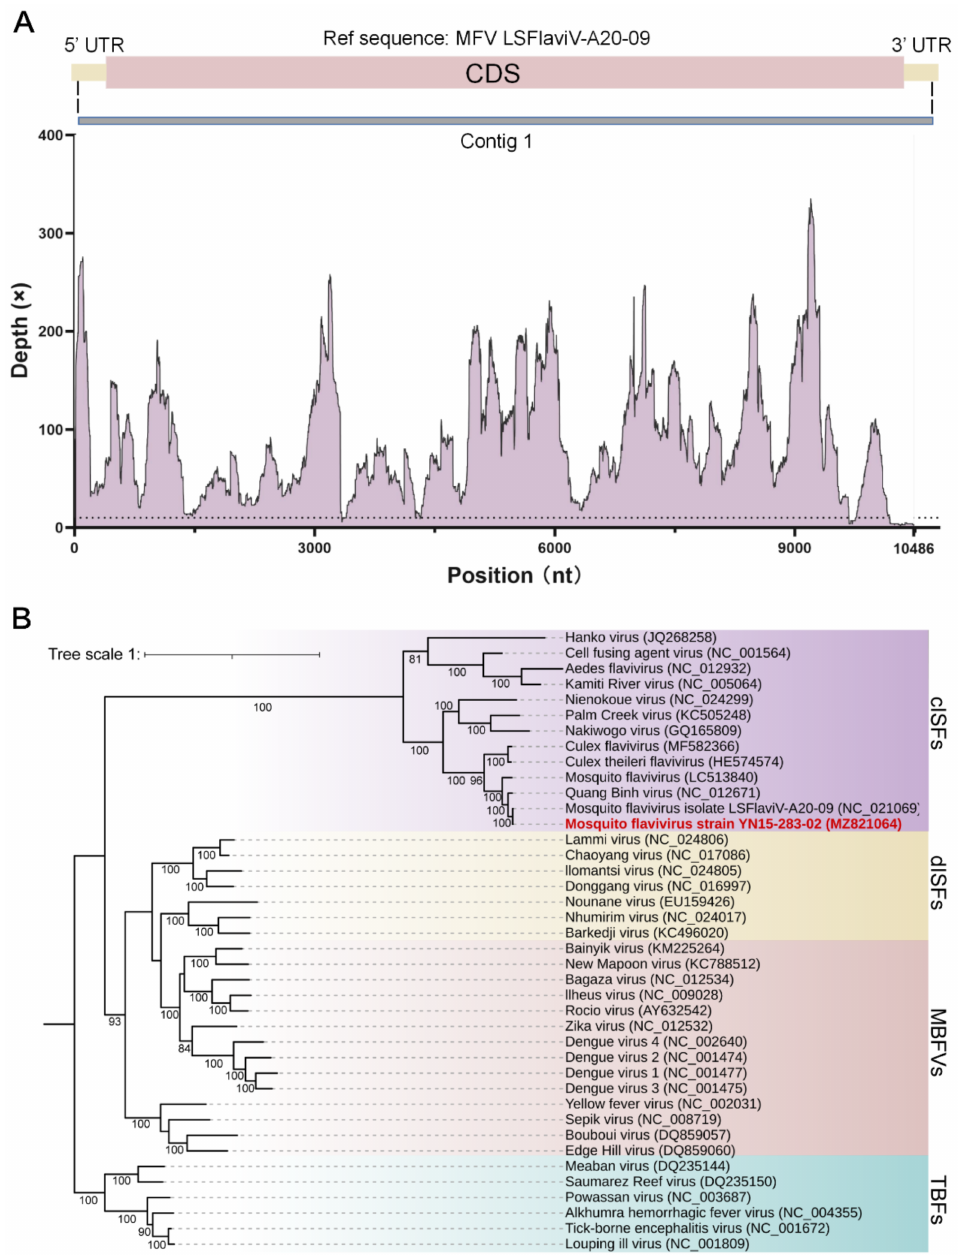
Figure 3. ( A ) The sequencing depth and the coverage of contig 1 when aligned to the reference sequence: MFV LSFlaviV-A20-09. The X-axis and Y-axis indicates position and sequencing depth, respectively. ( B ) Maximum likelihood tree was plotted based on conserved amino acid sequences of viral